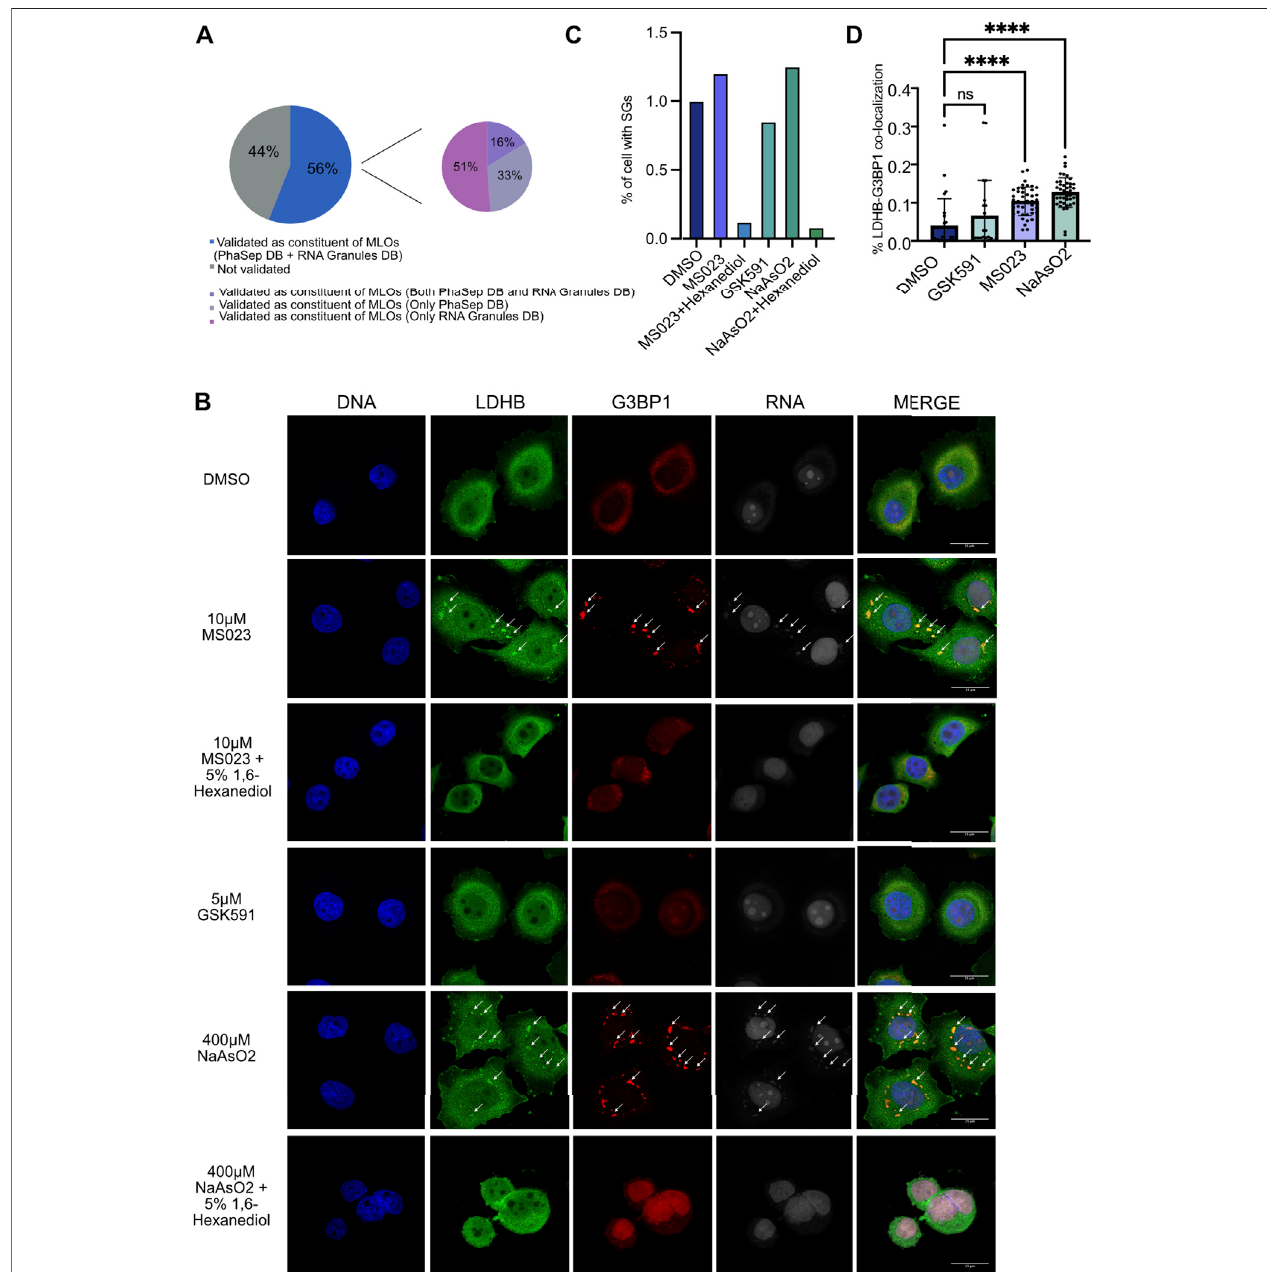
FIGURE 6 | MS023 treatment induces LLPS of candidate RBPs. (A) Tendency of MS023-modulated RBPs to undergo LLPS. Among the 77 proteins up-regulated intheinterfacefractionuponMS023,43(56%)werealsoannotatedasproteinsundergoingphaseseparationinatleastoneofthetwoPhaSepDB(http://db.phasep.pro/)and RNA Granules DB (http://rnagranuledb.lunenfeld.ca/) databases. Among them, 16% were annotated in both databases, 33% were annotated only in PhaSepDB and 51% were annotated only in RNA Granules DB. (B) Immuno fl uorescence (IF) analysis of LDHB in basal condition (DMSO) and in response to different treatments. RepresentativeIFimageshowsLDHBproteinsubcellularlocalizationinHeLacellstreatedwiththefollowingcompounds:DMSO,10 μ MMS023and5 μ MGSK591for48 h; 10 μ MMS023for48 h,followedby10 mintreatmentwith5%1,6-Hexanediol;400 µMNaAsO 2 for30 min,or400 µMNaAsO 2 for30 minfollowedby10min-treatmentwith 5% 1,6-Hexanediol. Immunostaining of RNA was performed with the Click-iT ™ RNA Alexa Fluor ™ 594 Imaging Kit. DAPI staining was used for nuclei visualization (DNA). G3BP1stainingwasusedaspositivecontrolforSGsformation.DAPI,LDHB,G3BP1andRNAstainingandtherespectivemergedimagesaredisplayed.Imagesweretaken bySP8confocalmicroscopyusinga60 × oilobjective,andascalebarof25 μ Mareincludedinthemerged fi gure.Arrowsindicateco-localizationoftargetRBP,G3BP1and RNA. (C) Bar-graphrepresentationofthepercentageofcellswithstressgranules.Thebar-graphshowsthepercentageofcellswithatleast1G3BP1-positivestressgranule (SG)for thedifferentconditions;allthetreatmentswerenormalizedoverDMSO. (D) Bar-graphrepresentationofthepercentageofLDHB-G3BP1co-localization. Theimage describesthepercentageofco-localizationbetweenG3BP1andLDHBintheSGsineachcondition.AllthetreatmentwerenormalizedovertheDMSO.Statisticalsigni fi cance was calculated by Student ’ t Test (* (cid:1) p < 0.05).